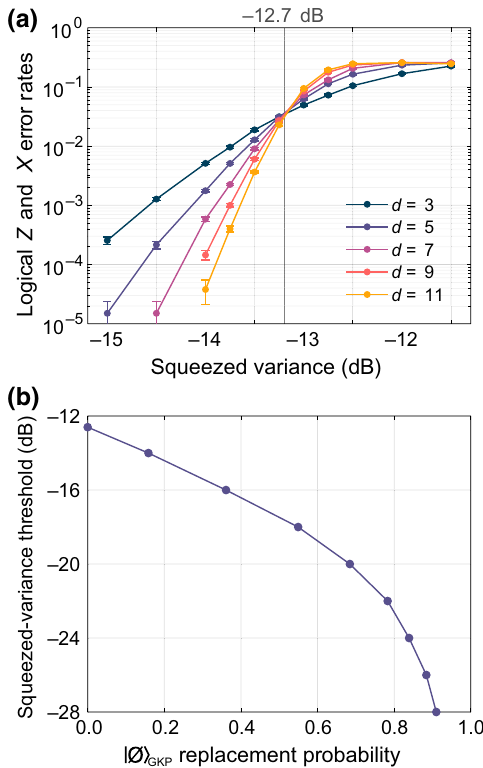
FIG. 5. (a) Simulated logical ˆ Z and ˆ X error probabilities for the surface-4-GKP code as a function of the (identical) squeez- states used for gate implementation, the GKP ing of the | 0 (cid:2) sq states used qubits encoding the surface code, and the | ∅ (cid:2) GKP for quadrature correction. The logical error probability is shown for different code distances d , and the fault-tolerant threshold where the logical error rate decreases with increasing code dis- tance is seen to be at 12.7 dB of squeezing. The error bars of standard deviation are estimated by bootstrapping. (b) Squeezing threshold of the surface-4-GKP code as a function of the proba- state is replaced with a | 0 (cid:2) state in bility with which a | ∅ (cid:2) GKP sq the resource preparation. Here, the threshold is estimated as the crossing point of the d = 7 and d = 9 logical error rates. For zero replacement probability, the threshold is that in